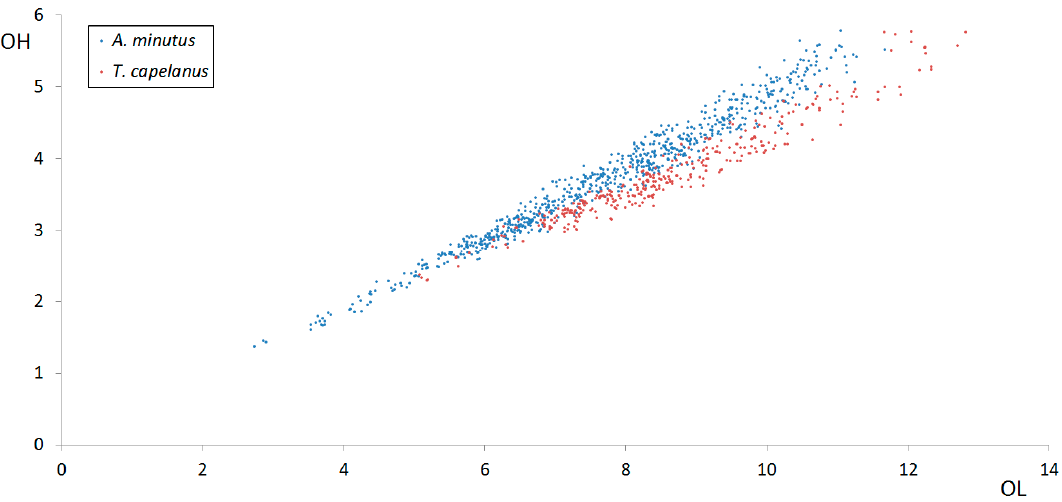
Figure 6 also shows, that OL/TL ratio of both species is not linear but allometric: the convex curves that can be constructed for the mean values demonstrate that otolith lengths of both species become relatively smaller in larger fishes. Although the smallest specimens are not available, it is logical thinking that the curves must start at the zero point of the graph. For T. luscus Merayo and Villegas [68] however suggest that the OL/SL ratio (which is comparable with the OL/TL ratio) can be considered linear, but although they do not present a graph, their mean line clearly cannot start at the zero point because of the equations in the upper part of their Table 1. Their conclusion that the mean development of the OL/SL ratio follows a straight line is not true. In the last sentence of their section on otolith growth on page 117, they were aware of the negative allometry of this relationship because the power functions proved significantly different from 1.